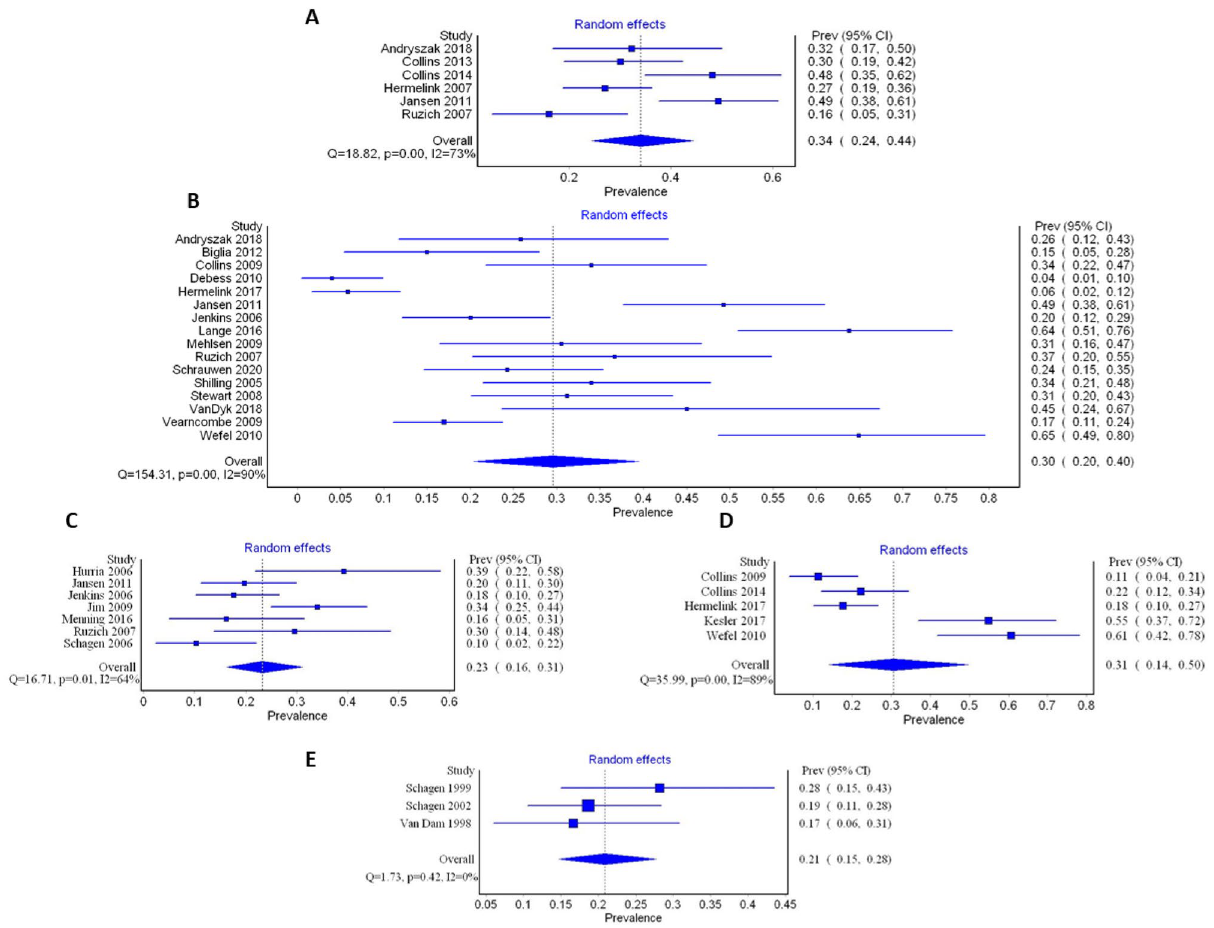
Figure 5. Forest plots of prevalence reported in studies utilising neuropsychological tests to diagnose cognitive impairment following chemotherapy treatment for breast cancer. ( A ) Cognitive assessment undertaken during chemotherapy treatment (T1), ( B ) Cognitive assessment undertaken just after cessation of chemotherapy treatment (T2), ( C ) Cognitive assessment undertaken 6 months after cessation of chemotherapy treatment